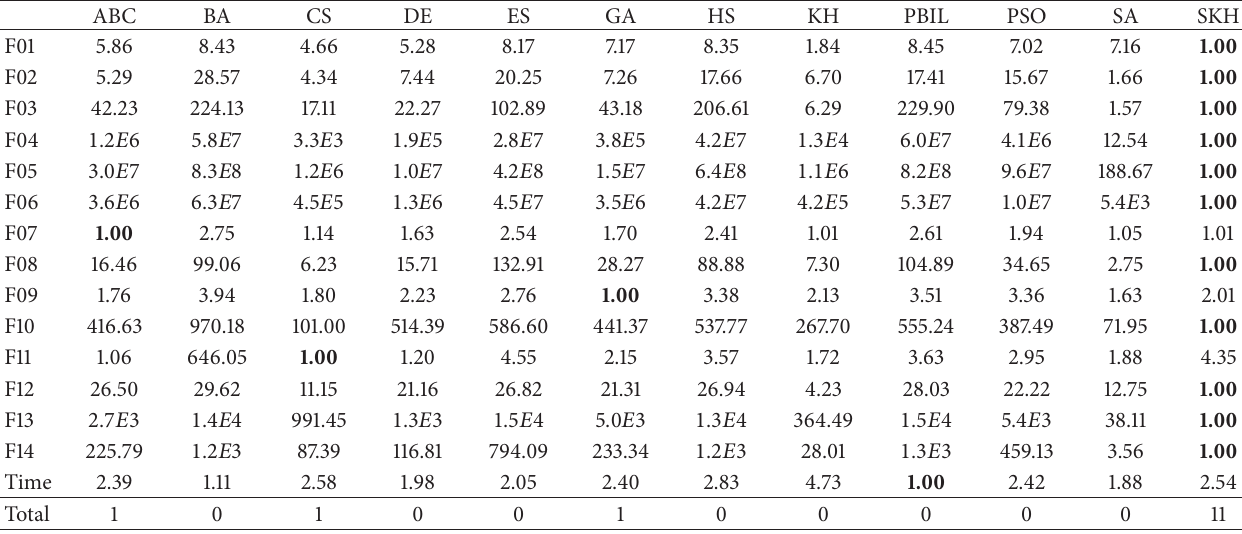
Table 1: Mean normalized optimization results in fourteen benchmark functions.